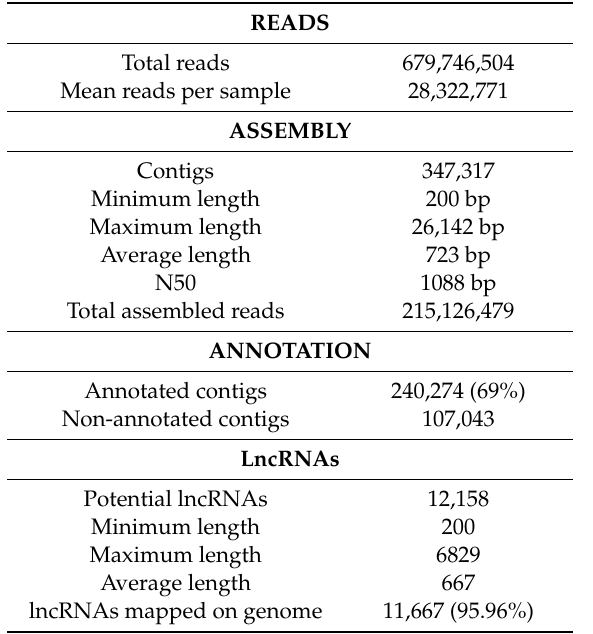
Table 1. Summary of the Illumina sequencing, assembly, annotation and lncRNA